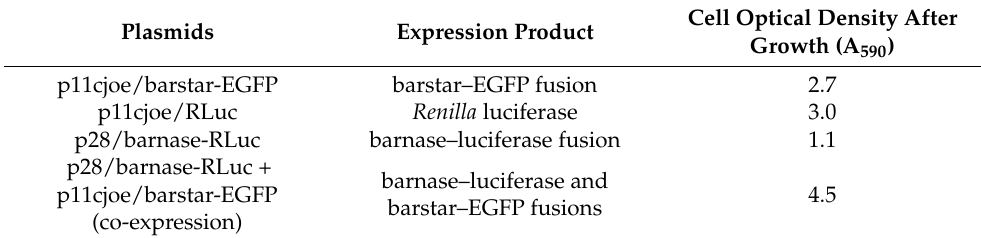
Table 1. E. coli cell growth after transformation with plasmids